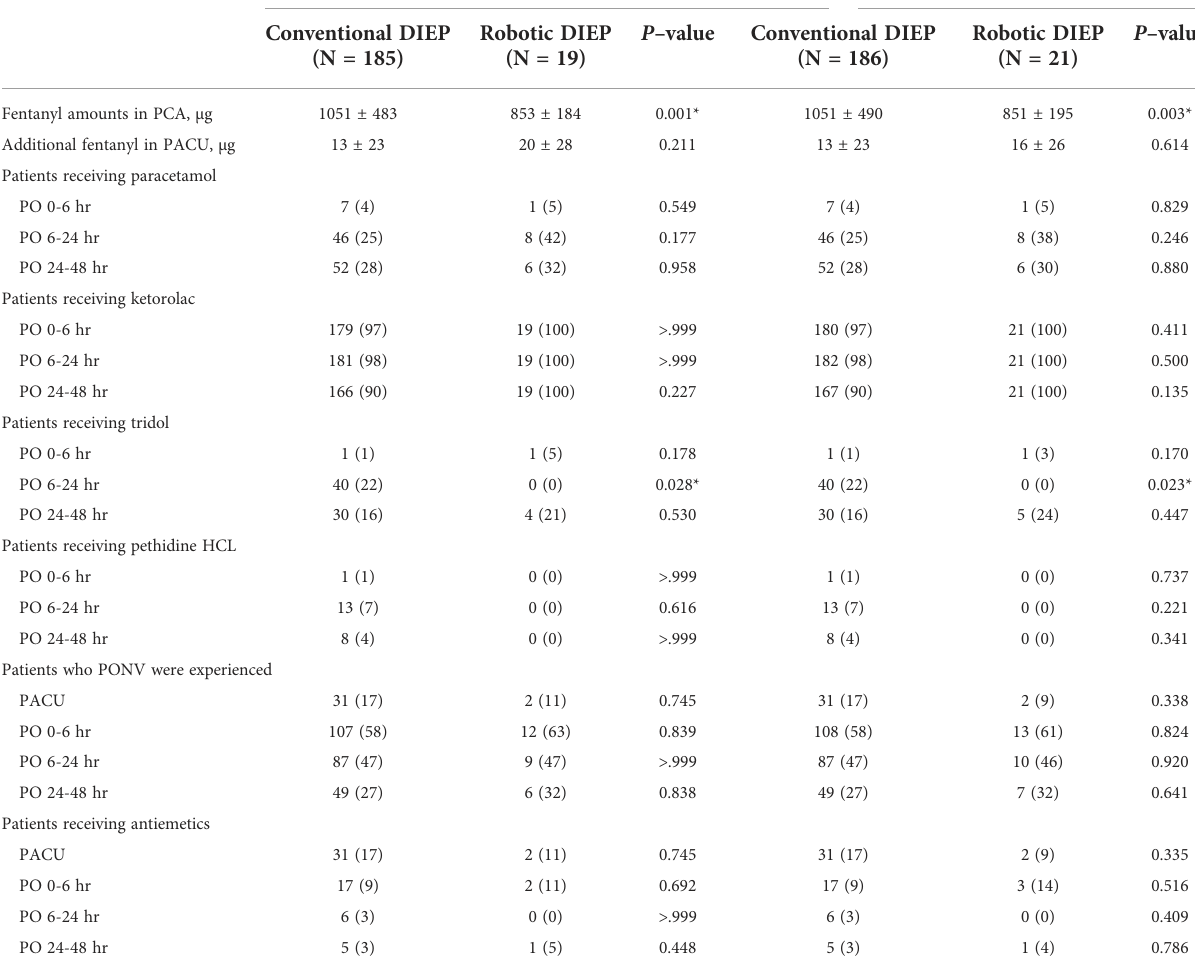
TABLE 4 Postoperative nausea and vomiting, and analgesics pro fi le. Variables Before IPTW